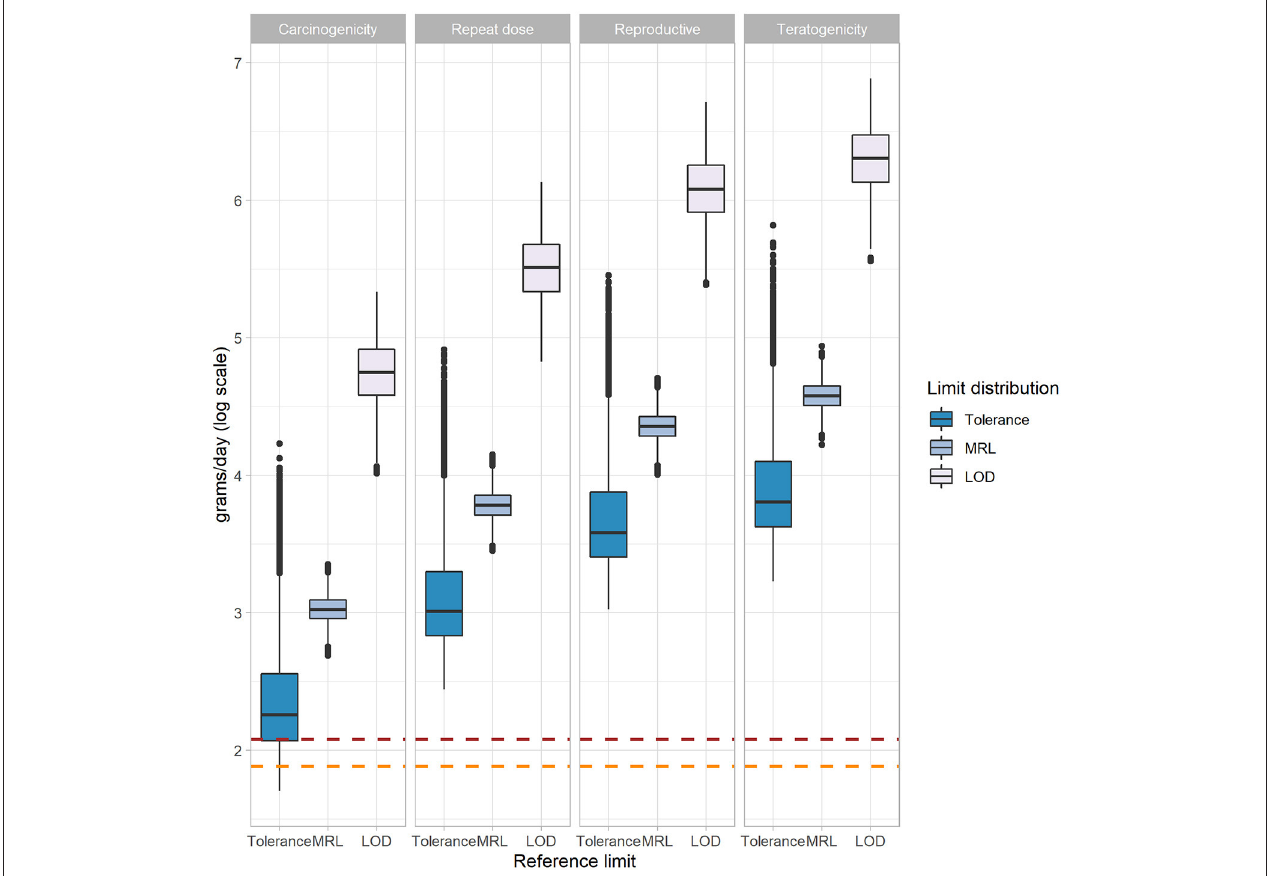
FIGURE 2 | Comparison of three stochastic processes applying tolerance, MRL, and LOD distributions for four different NOAELs in a box plot to calculate human consumption (log grams/day) of pheasant tissues contaminated with fenbendazole sulfone residues to have observed adverse effects. Boxplots are visualized using minimum (Q1 − 1.5 × IQR), first quantile (Q1), median (Q2), third quartile (Q3), and maximum values (Q3 + 1.5 × IQR). IQR is interquartile range. Outliers are represented using points. Brown dotted line, log most likely value for US consumption distribution (119.55 g/day); orange dotted line, log most likely value for